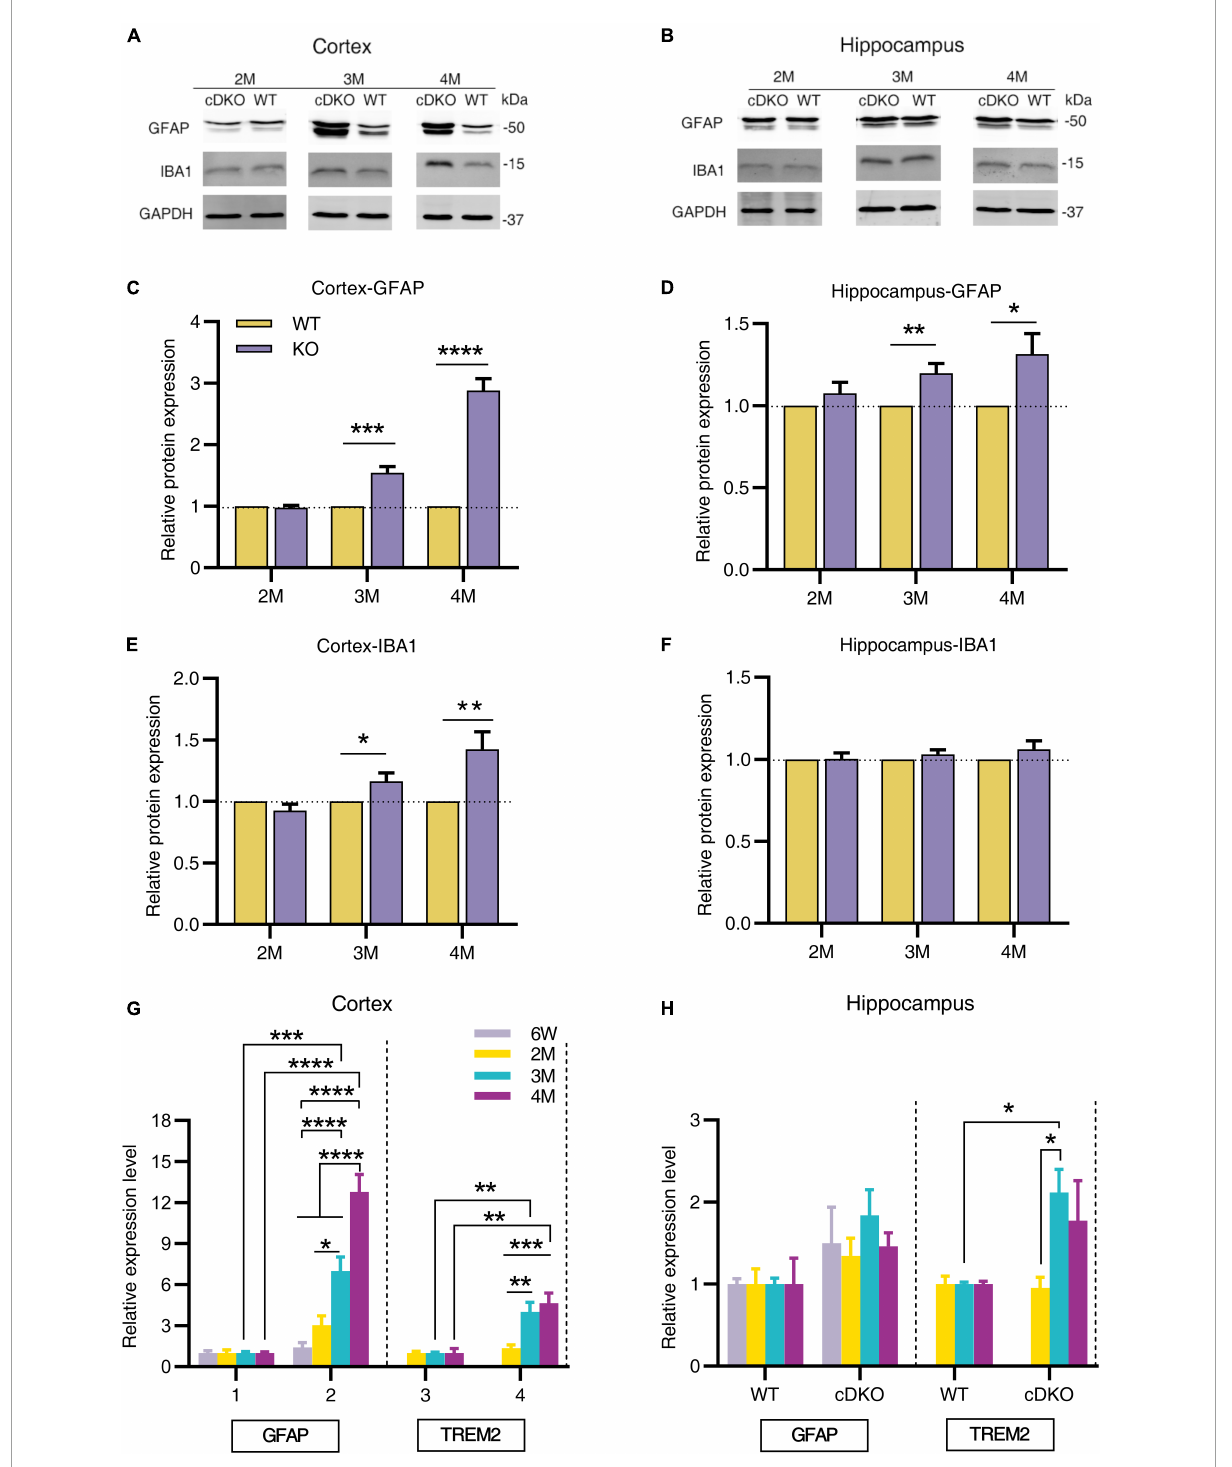
FIGURE1 Progressive increase in protein and mRNA expression of glial genes in cDKO mice. (A,B) Representative Western blots of astrogliosis marker GFAP and microgliosis marker IBA1 in the cortex (A) and hippocampus (B) from the 2-, 3-, 4-month-old (2, 3 and 4 M) WT and cDKO mice. (C–F) Quantification of relative levels of GFAP and IBA1 as normalized to GAPDH protein expression (Cortex, 2 M: n = 6; 3 M: n = 7; 4 M: n = 8; Hippocampus, 2 M: n = 3; 3 M: n = 6; 4 M: n = 6). Data are presented as the mean ± SEM. * P < 0.05, ** p < 0.01, *** p < 0.001, **** p < 0.0001, unpaired two tailed t -test. (G,H) Relative mRNA expression of GFAP and TREM2 normalized to GAPDH in the cortex (G) and hippocampus (H) of WT and cDKO mice at the ages of 6 weeks, 2, 3, and 4 months analyzed by RT-PCR. Data are presented as the mean ± SEM ( n = 3–5 for each group). One-way ANOVA analysis followed by Turkey’s test, * p < 0.05, ** p < 0.01, *** p < 0.001, **** p <